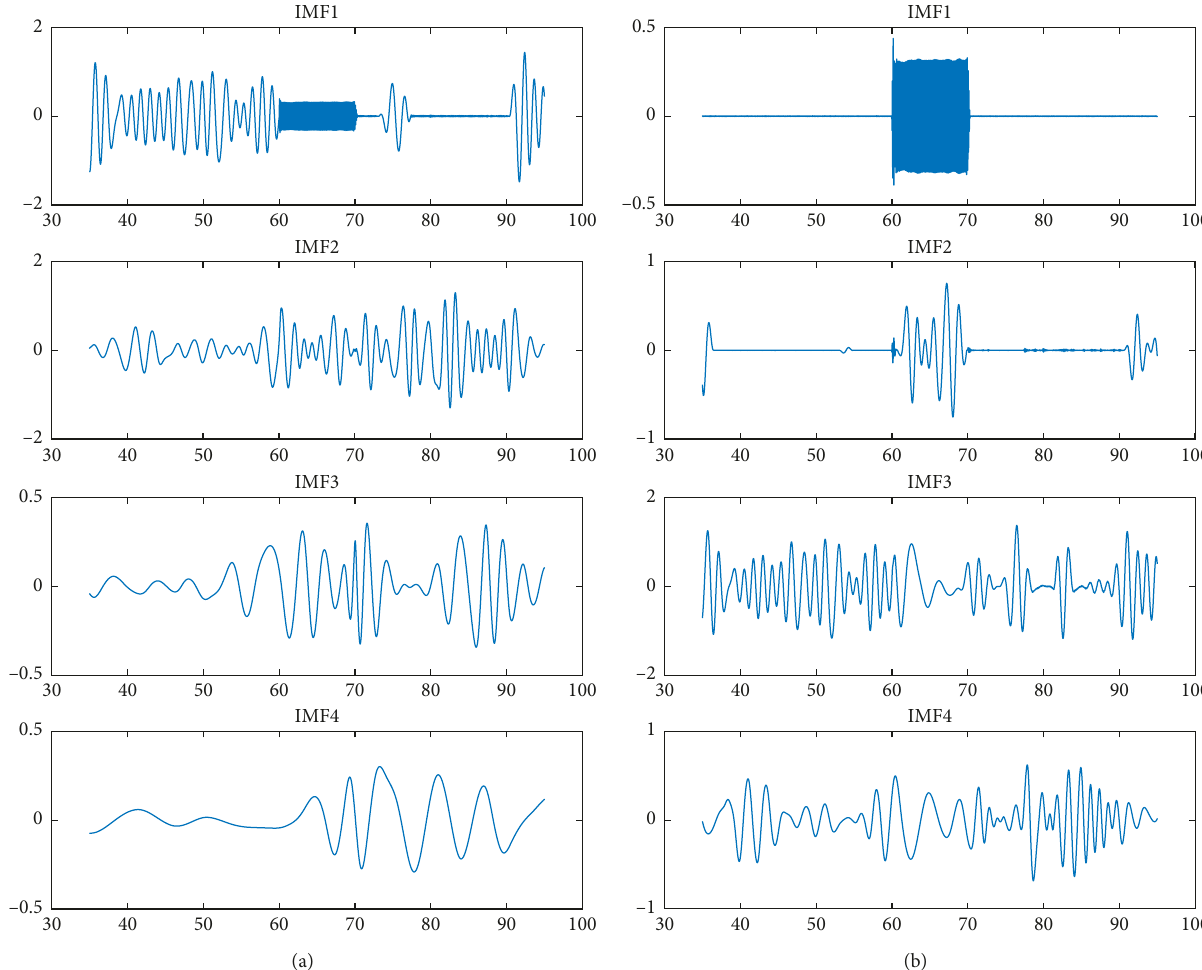
Figure 9: The first four IMFs of the signal. (a) EMD. (b) EEMD.